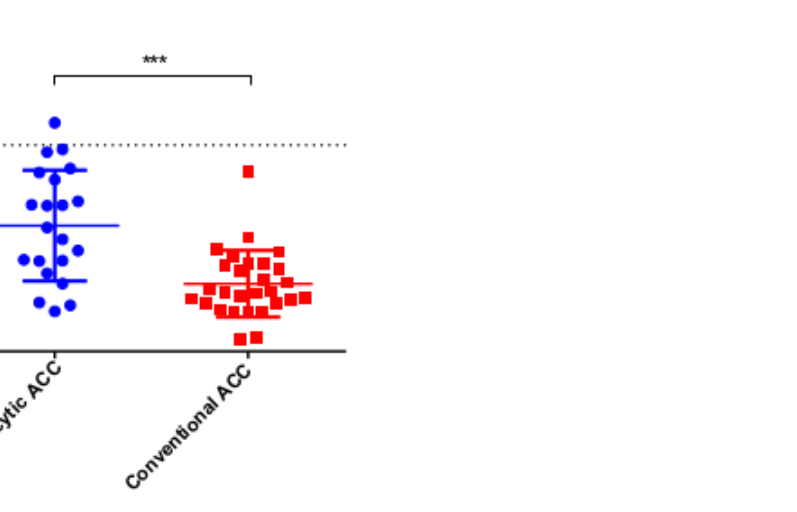
Figure 5. The immune score of TCGA ACC tumor [16] samples based on CIBERSORTx algorithm (*** p -value = 0.0002).